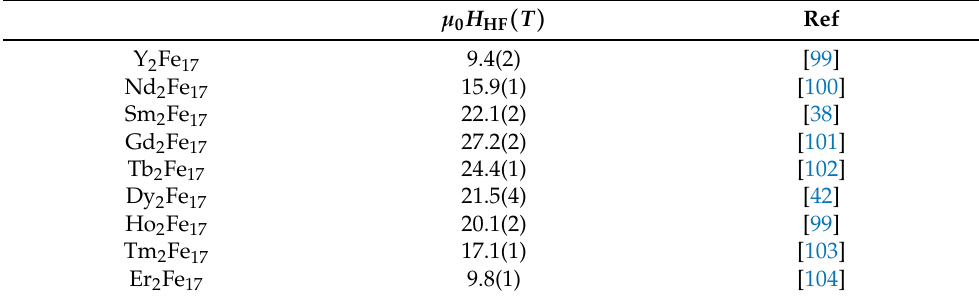
Table 7. Hyperfine parameters of R 2 Fe 17 − x